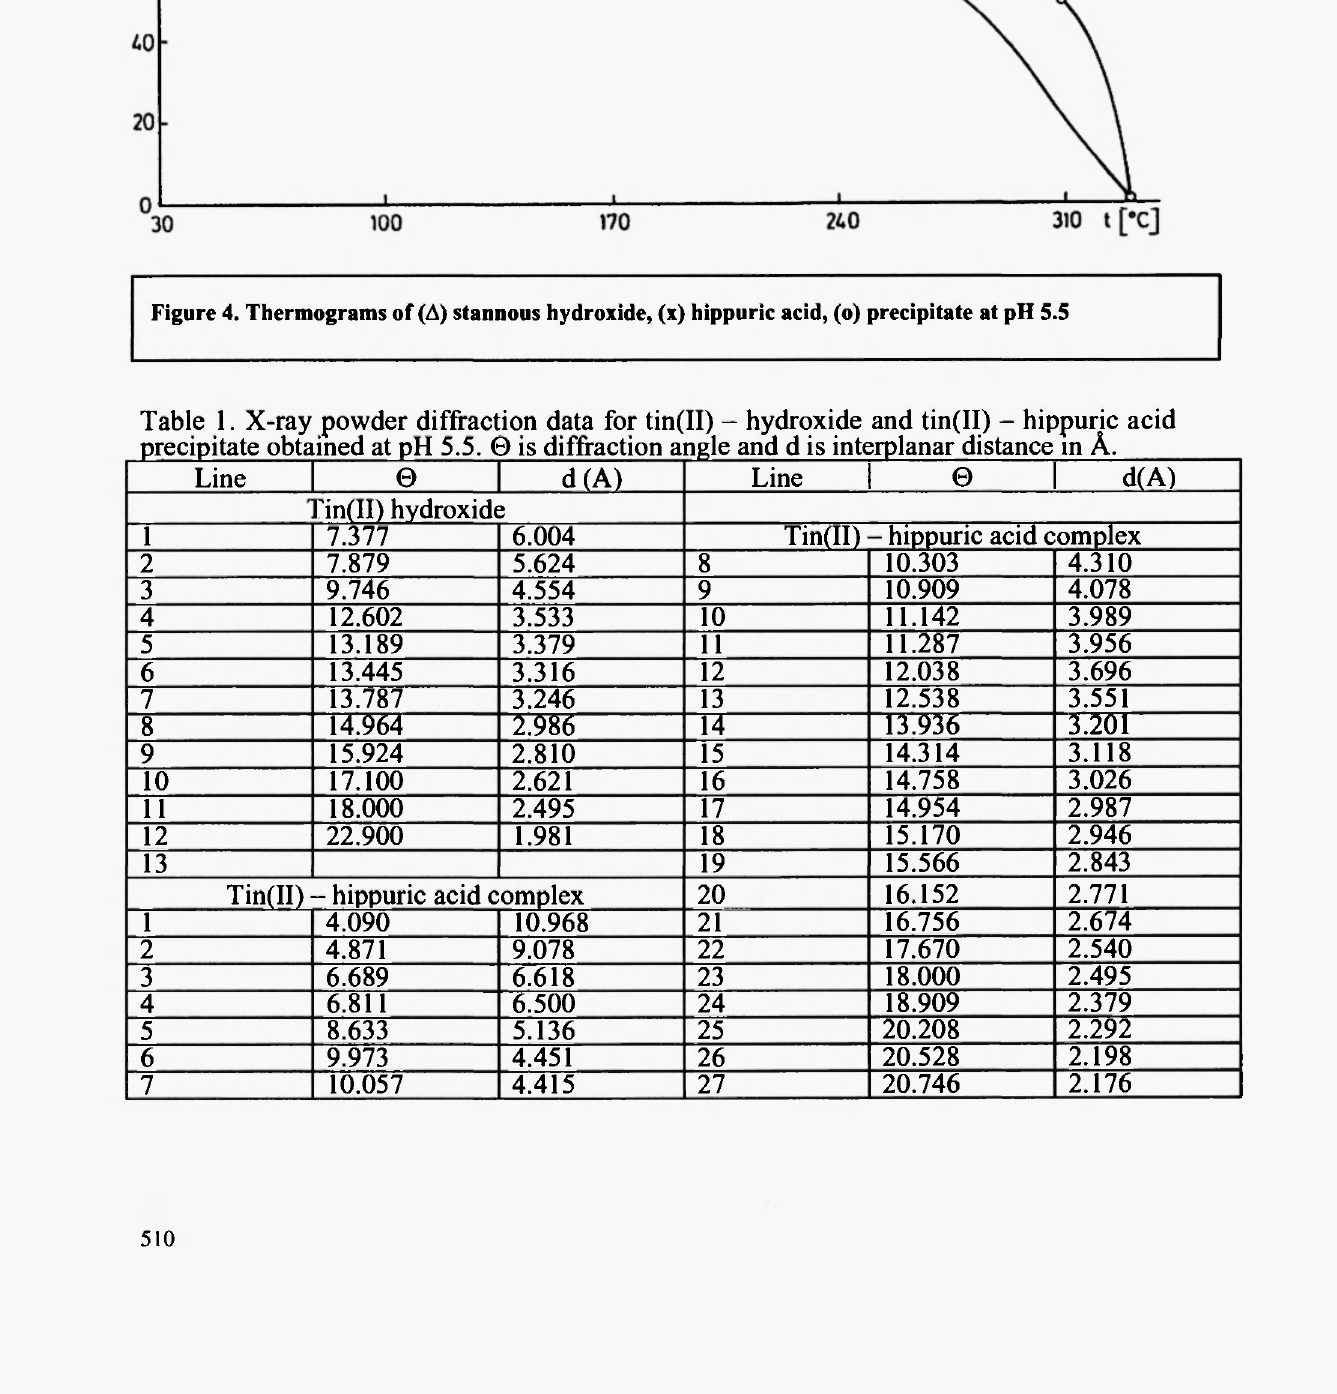
Figure 4. Thermograms of (Δ) stannous hydroxide, (x) hippuric acid, (o) precipitate at pH 5.5